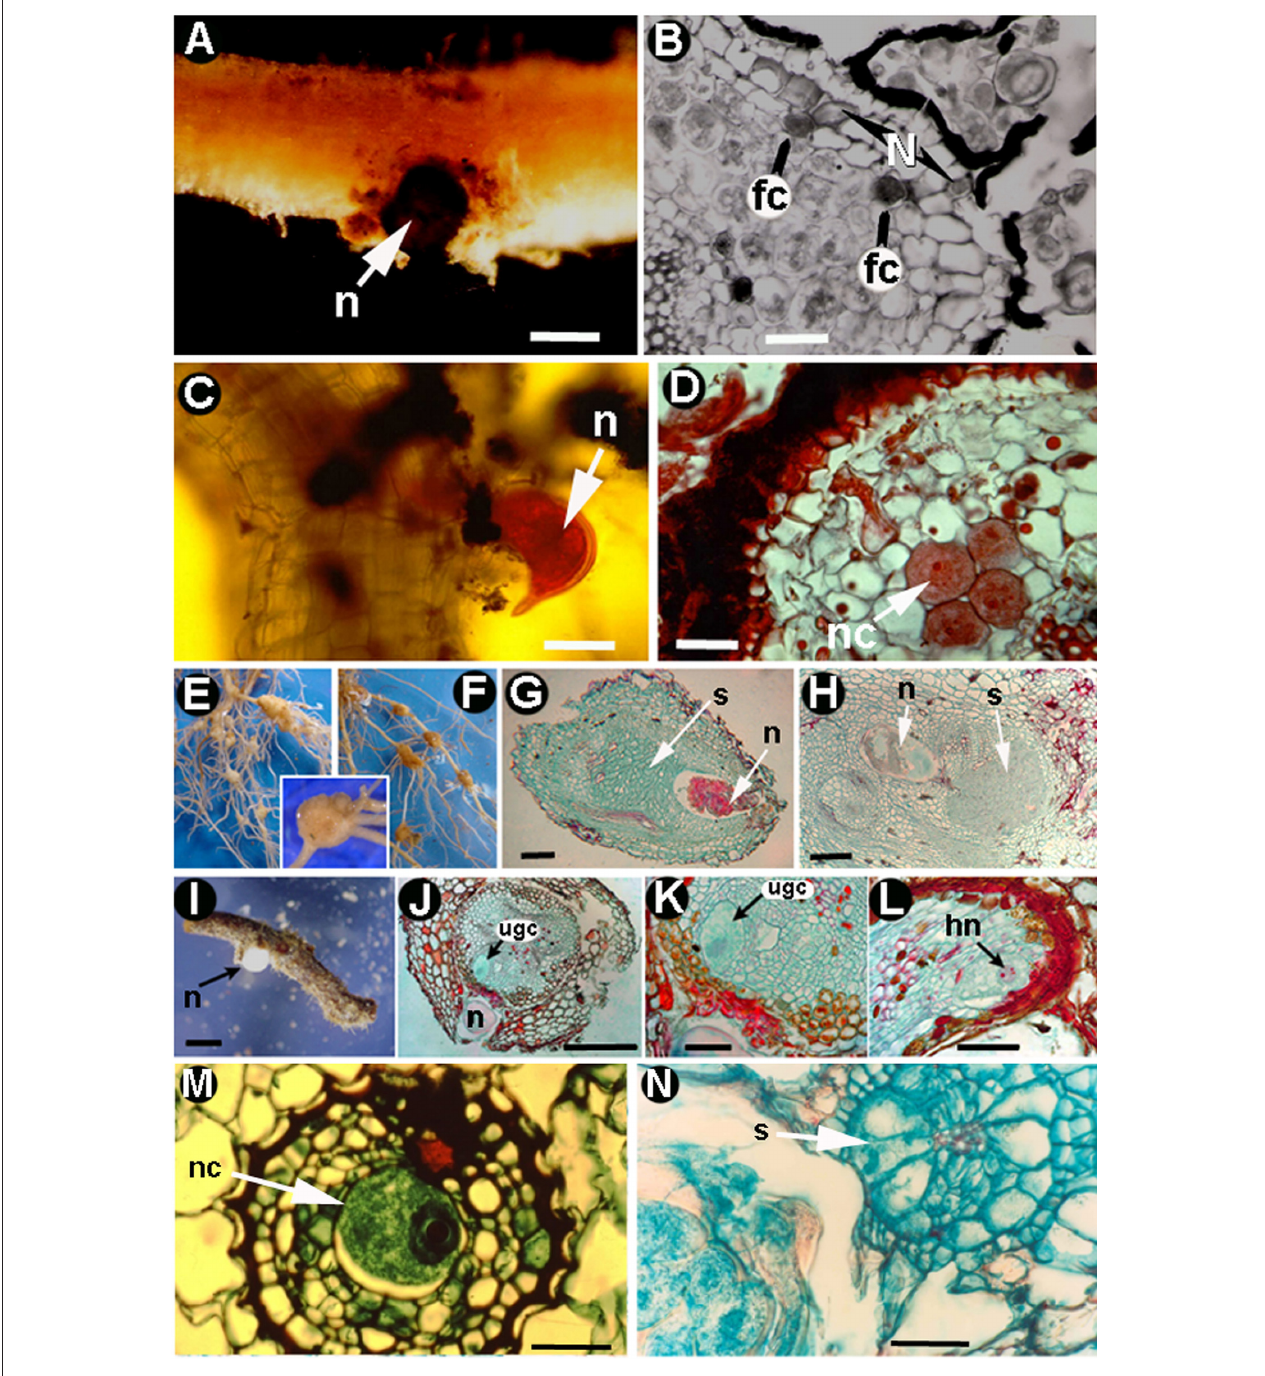
FIGURE 5 | Morphogenesis in root nematodes: other root endoparasites (A–N). Trophotylenchulus obscurus (A,B) : (A) Nematode (n) parasitizing coffee root. (B) Cross section of coffee root showing feeding cells (fc) with no evident increase in size and the nematode (Source: N. Vovlas). Tylenchulus semipenetrans (C,D) : (C) Nematode (n) parasitizing citrus root. (D) Cross section showing induced nurse cells (nc) with dense cytosols (Source: N. Vovlas). Nacobbus aberrans (E–H) . (E,F) Tomato roots infected by the nematode showing knobs. (G,H) Cross sections of tomato roots showing the nematode (n) and the induced syncytium (s) (Vovlas et al., 2007; with permission of Journal of Nematology). Cryphodera brinkmani (I–L) : (I) Root segment of pine with the posterior portion of the body of a white female (n) protruding from the root surface. (J–L) Cross sections of pine roots showing nematode female body (n) embedded in the cortical parenchyma and an uninucleate giant cell (ugc) with hypertrophied nucleus (hn) (Vovlas et al., 2013; with permission of Springer). (M) Cross section of corn root infected by Meloidodera charis showing the single nurse cell (nc) (Source: N. Vovlas). (N) Cross section of Mentha aquatica root infected by Meloidoderita kirjanovae showing the syncytial formation (s) (Vovlas et al., 2006; with permission of Journal of Nematology). Fc, feeding cell; hn, hypertrophied nucleus; n, nematode; nc, nurse cell; s, syncytium; ugc, uninucleate giant cell. Scale bars: A,I = 500 µ m; B,G,H,N = 50 µ m; C,D,J–M = 100 µ m.